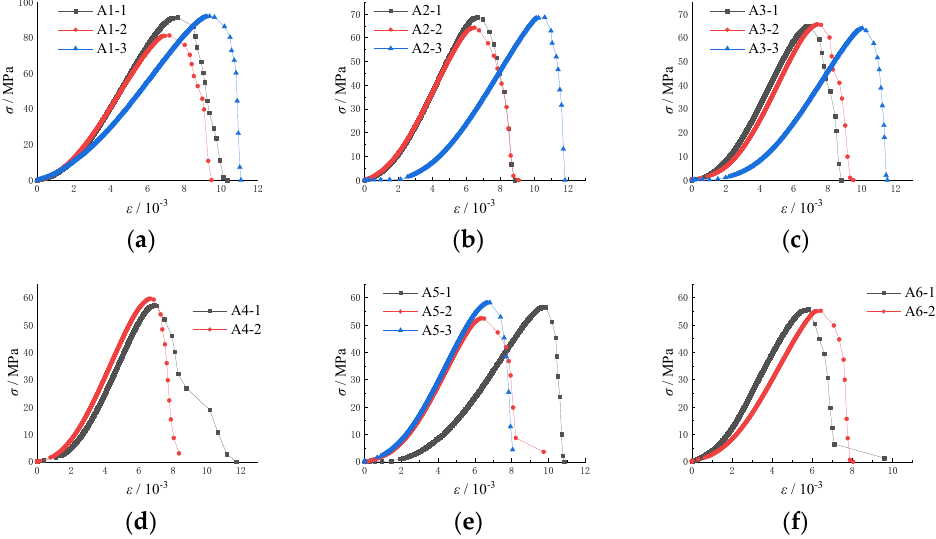
Figure 4. The uniaxial compression test results of sandrock containing water. ( a ) Dry Sample; ( b ) Sample Submerged for 0.75 h; ( c ) Sample Submerged for 1.5 h; ( d ) Sample Submerged for 6 h; ( e ) Sample Submerged for 24 h; ( f ) Sample Submerged for 720 h.